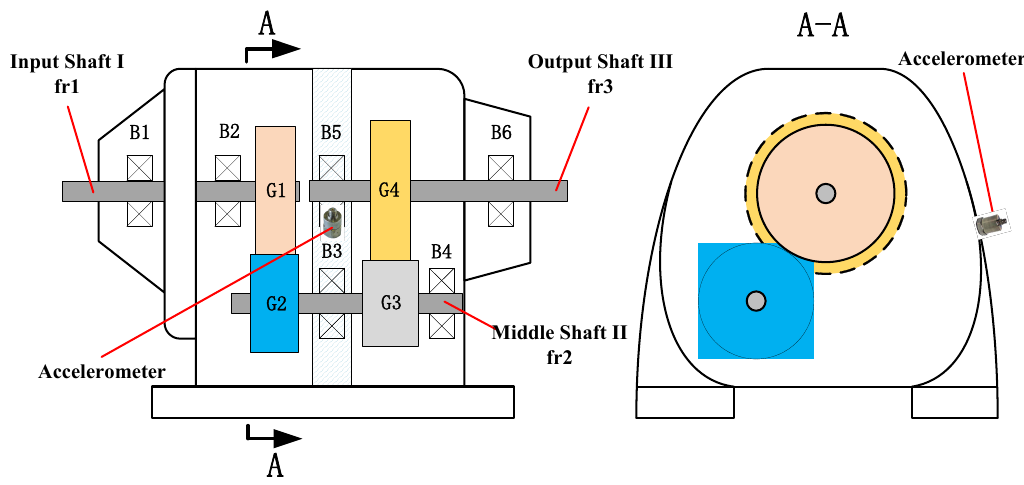
Figure 15. The schematic diagram of bearings in the 10 kW two-stage helical gearbox.